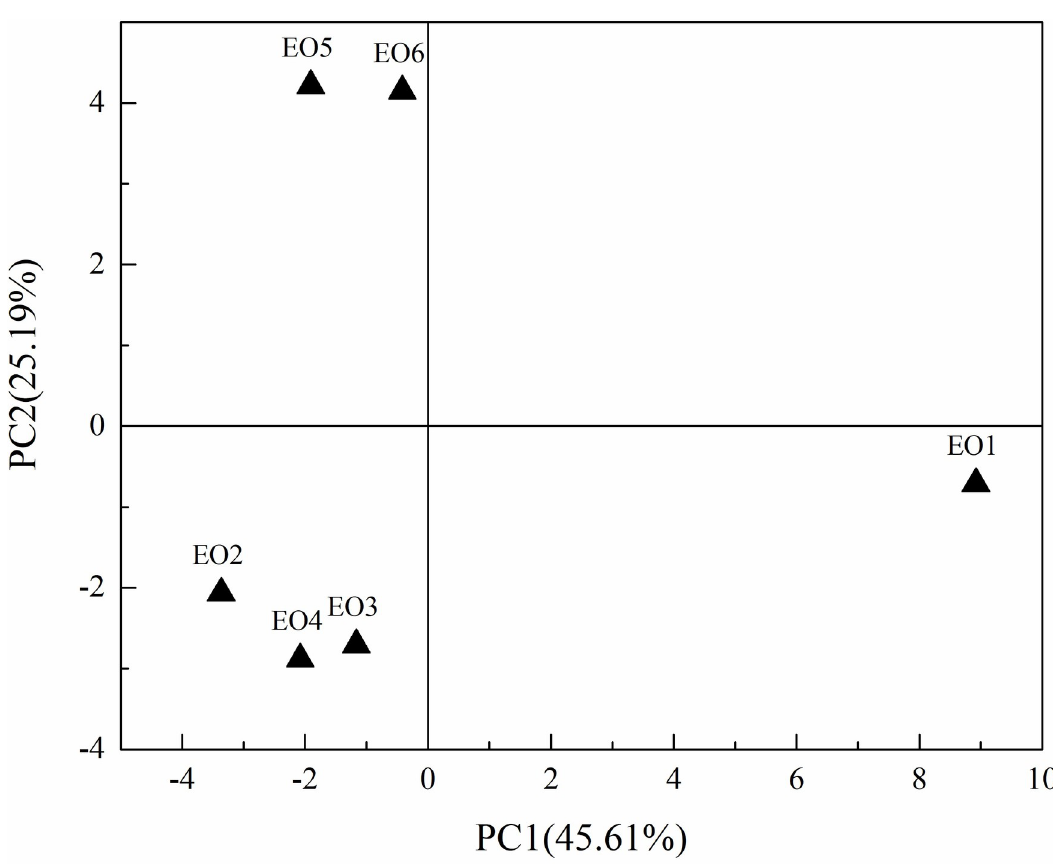
Fig 5. The score-plot of PCA for six EOs of Luodian B . balsamifera .